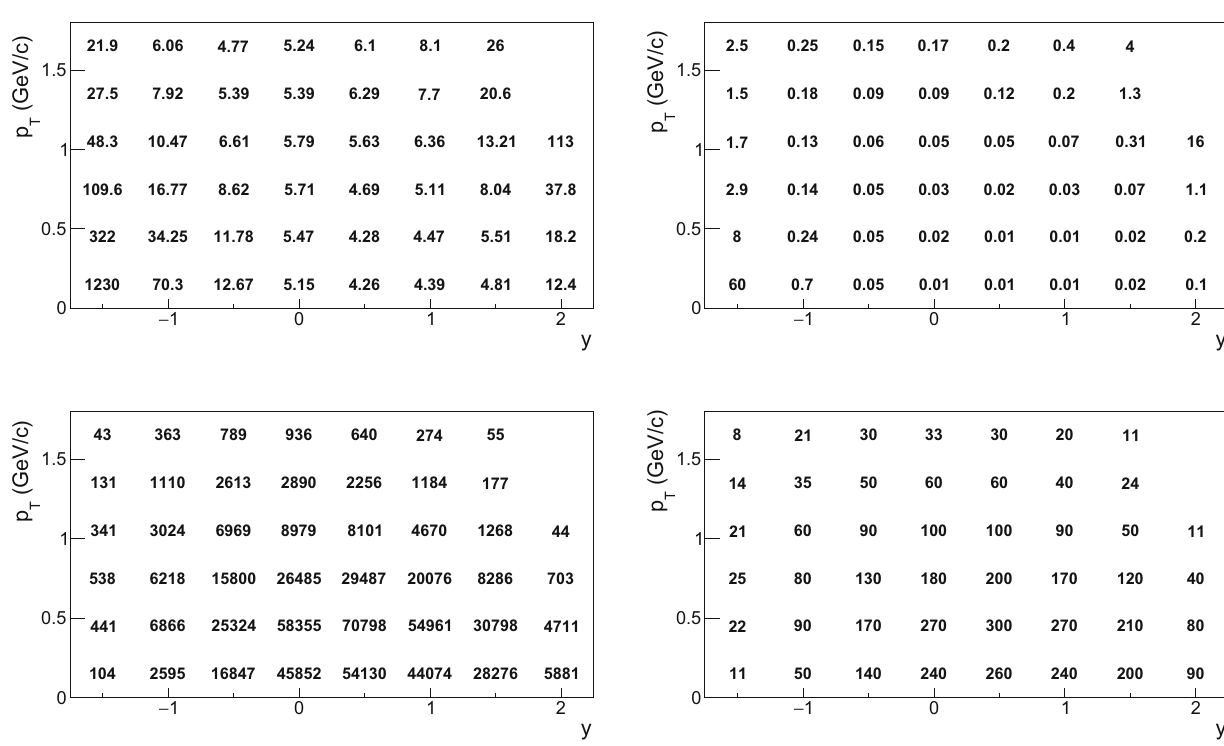
Fig. 6 Top : Monte-Carlo correction factors (see Eq. 2) in each ( y , p T ) bin ( left ) and corresponding statistical uncertainties ( right ). Bottom : uncorrected bin-by-bin multiplicities of K 0 ( left ) and statistical uncertainties ( right ) S integration window, the uncorrected number of K 0 was cal- were reconstructed with the same software as used for real S culated by subtracting bin-by-bin the fitted background and events and the same selection cuts were applied and d E / d x summing the background-subtracted signal in the mass win- identification was replaced by matching of simulated dow m 0 ± 3 (cid:9) (dashed vertical lines), where m 0 is the fitted . The latter agrees with the PDG value within mass of the K 0 S statistical uncertainties. Figure 5 shows that the simulation mass distribution and reproduces the central value of the K 0 S somewhat underestimate its width. To calculate the signal from the simulation, the (cid:9) parameter fitted to the simulation was used. Thus a possible bias due to differences between the data and simulation is reduced, see Sect. 3.8.